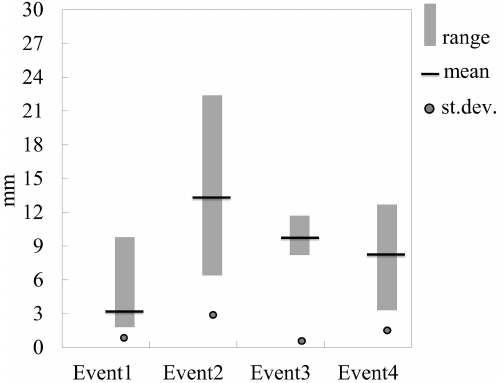
Figure 2. Characteristics of the four selected storm events: rainfall volume range (maximum and minimum for all 100m × 100m pix- els over the catchment area), mean and standard